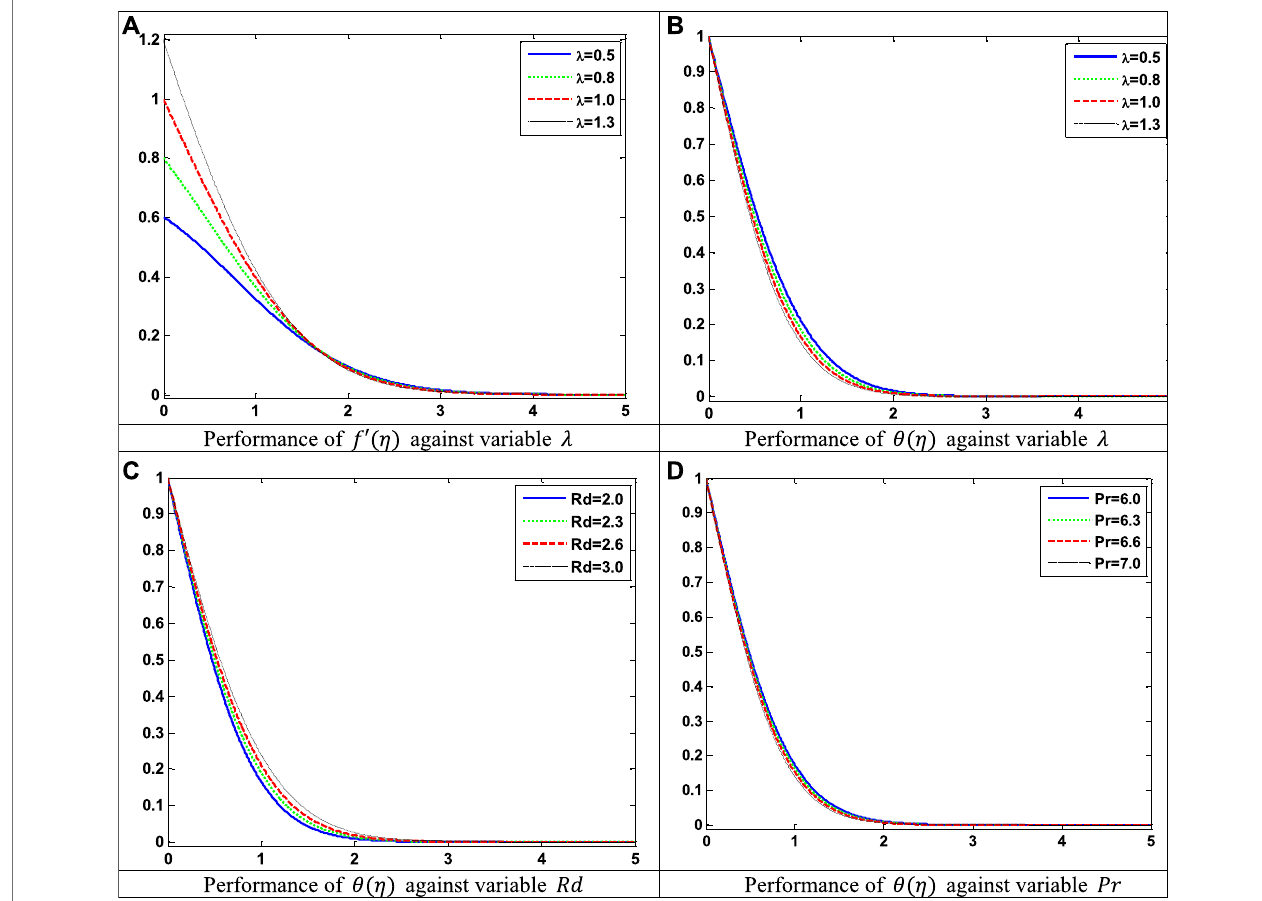
FIGURE 4 | Variation of velocity and temperature pro fi le against λ and Pr .